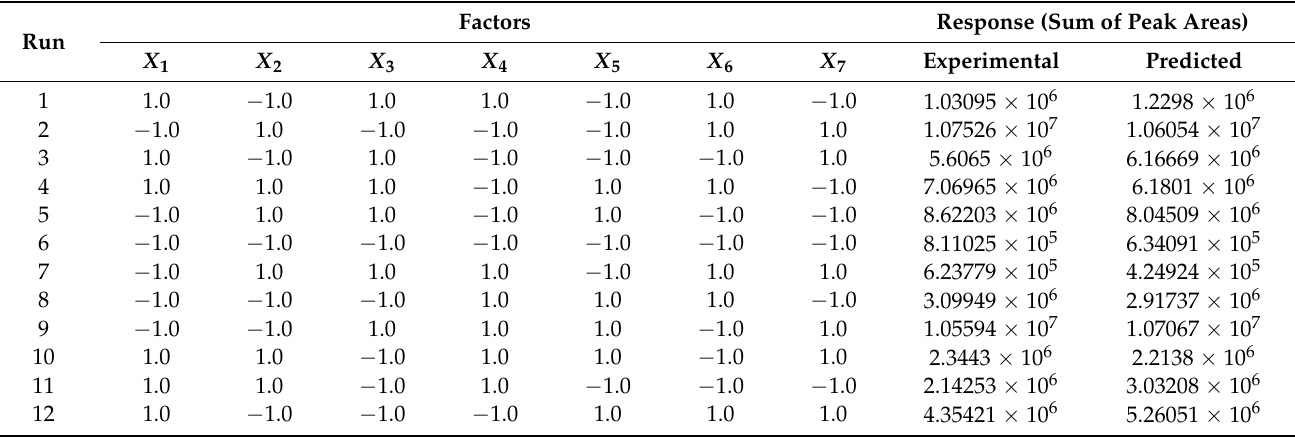
Table 1. Experimental and predicted values of the standardized areas based on a Placket–Burman screening design of the enzymatic